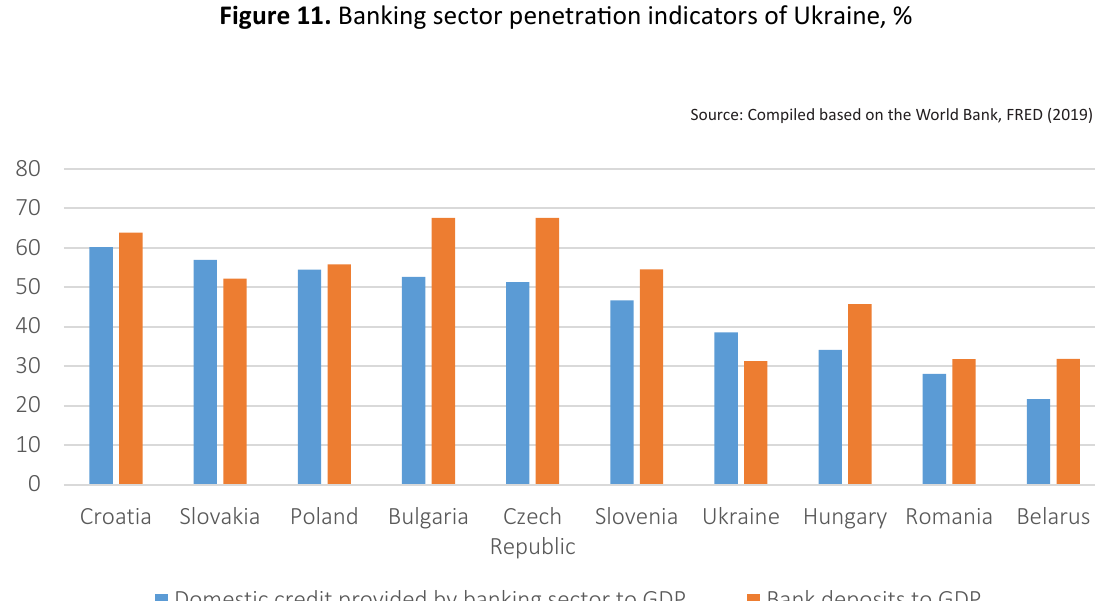
Figure 11. Banking sector penetration indicators of Ukraine, %